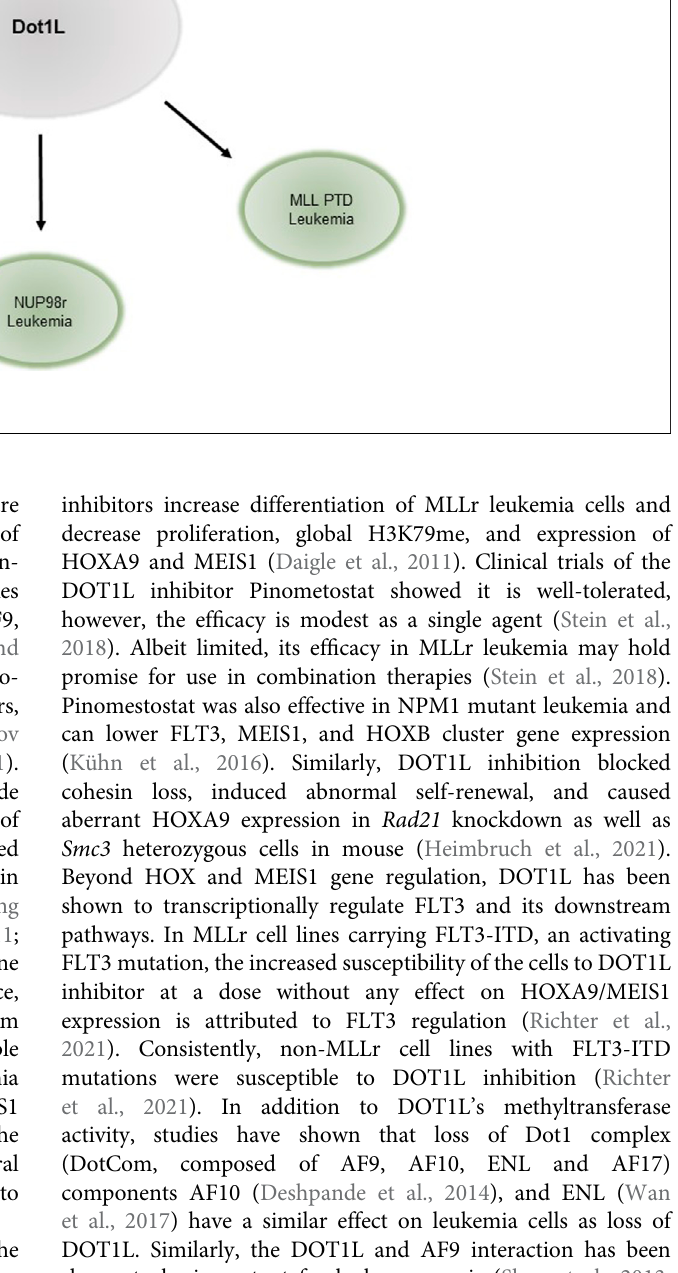
Frontiers in Cell and Developmental Biology |